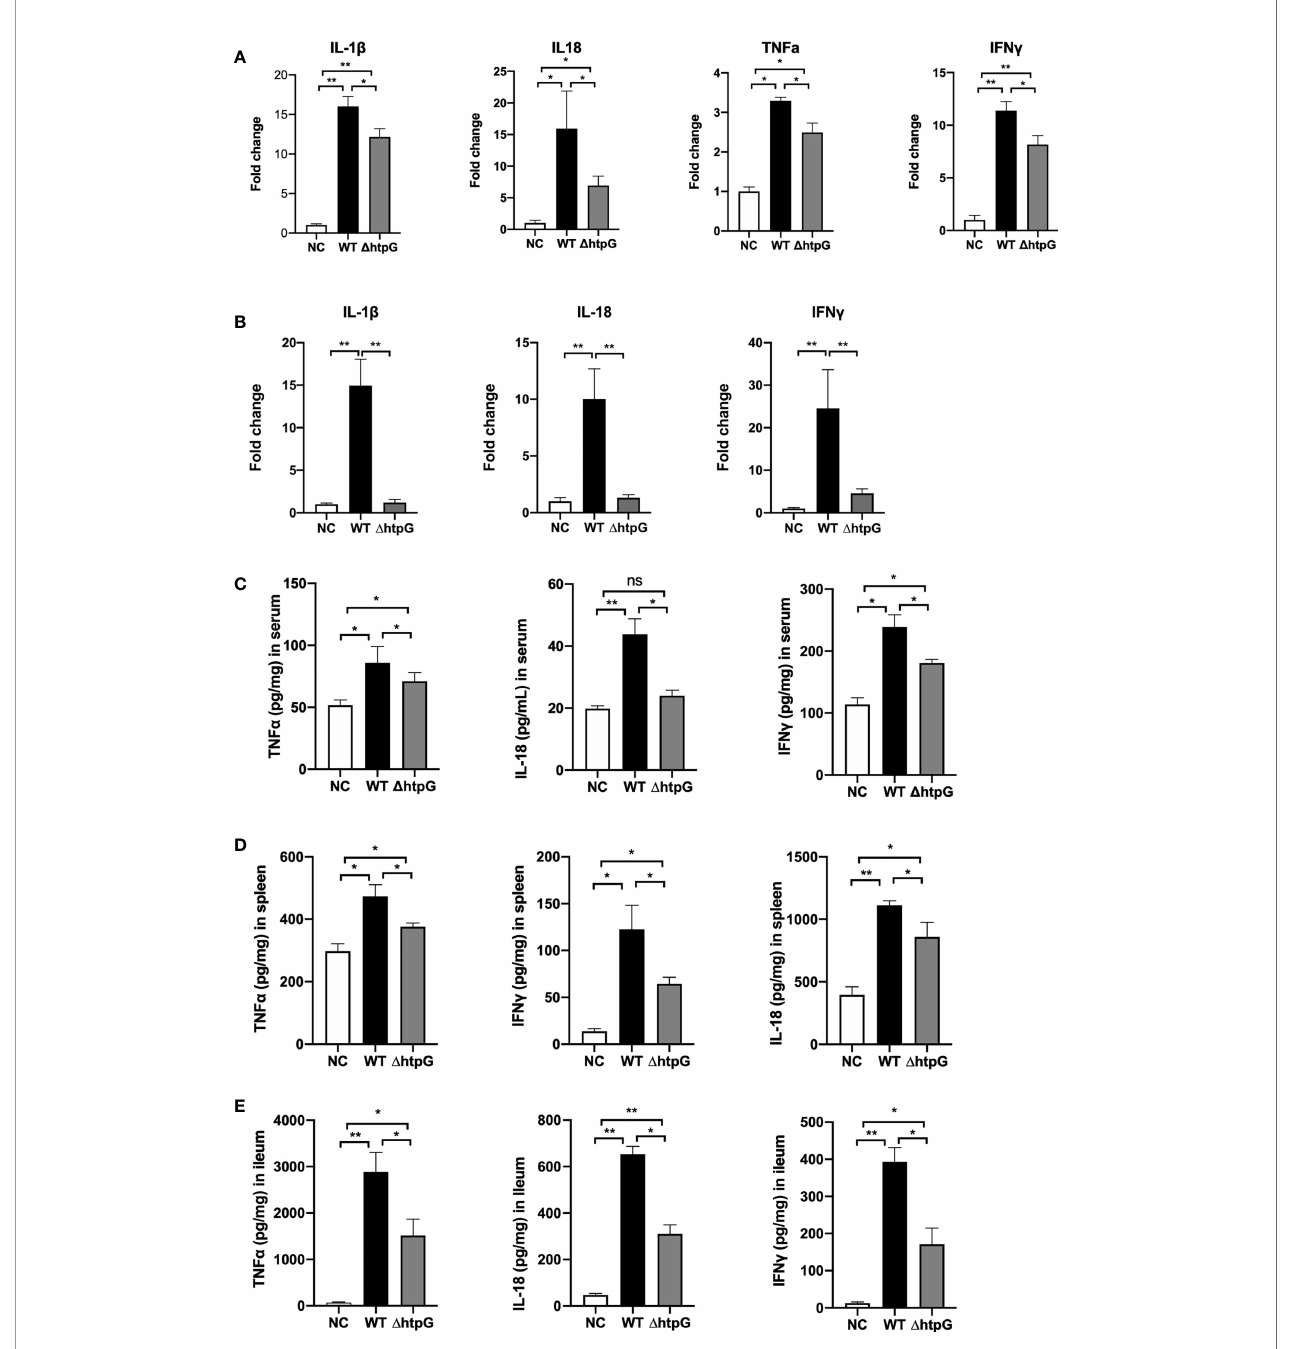
FIGURE 5 | Pro-in fl ammatory responses of mice induced by S. Typhimurium. Relative mRNA expression in spleen (A) and ileum (B) after infection for 4 days with S. Typhimurium. The content of in fl ammatory cytokines in the serum (C) , spleen (D) , and ileum (E) of mice infected by S. Typhimurium. * means p < 0.05, ** means p < 0.01, n =